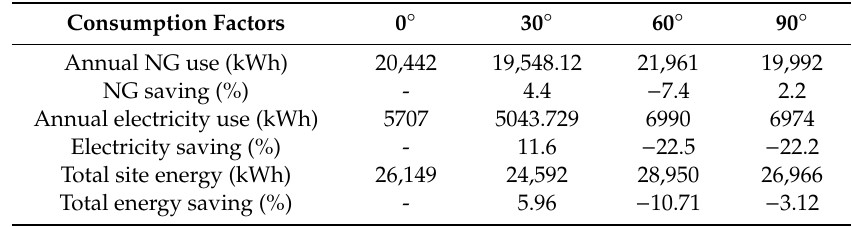
Figure 8. Monthly electricity consumption for different building orientations (°). Table 8. The annual energy consumption and energy saving for various building orientations.